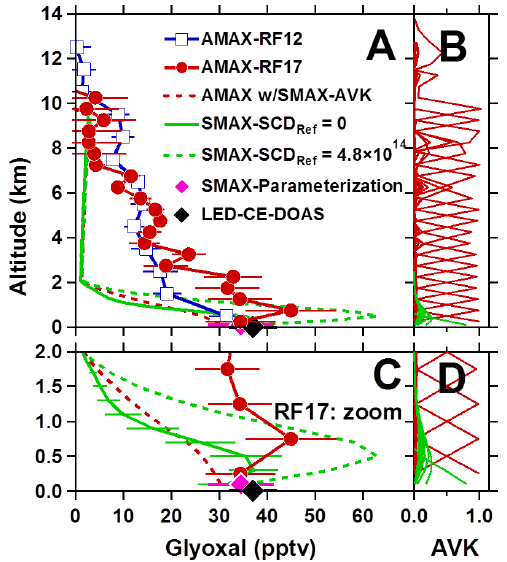
Figure 8. Glyoxal vertical profiles and comparison with indepen- dent validation data on the ship. (a) AMAX-DOAS during RF12 (blue squares) and RF17 (red dots) is compared with LED-CE- DOAS (black diamond) and SMAX-DOAS parameterization (ma- genta diamond) and optimal estimation retrievals (green lines); (b) shows AVK for glyoxal from RF17 (red) and SMAX-DOAS (green); (c) is the same as (a) but with only RF17 data and zoomed for the lower 2km. SMAX profile inversion of dSCDs is the solid green line; SCD REF = 4 . 8 × 10 14 moleccm − 2 glyoxal is the dashed green line; simulated SMAX-DOAS view of the AMAX profile using Eq. (2) is the red dashed line; see Sect. 3.4 “Sensitivity of MAX-DOAS profiles to SCD REF ” for details. (d) is the same as (b) , zoomed for the lower 2km. The error bars are based on propa- gating fit errors through the